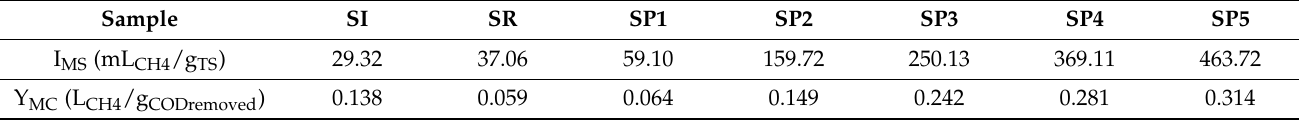
Table 3. Values of I MS and Y MC calculated at the end of BMP tests.